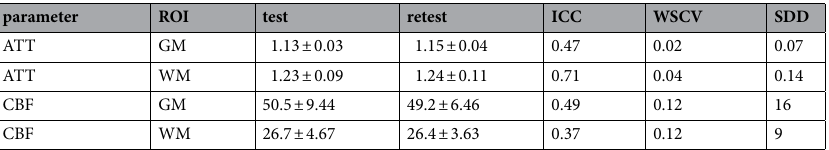
Table 1. Perfusion parameter results. Mean arterial transit time (ATT [s]) and cerebral blood flow (CBF [ml/100 g/min]) and statistical test–retest results (ICC, WSCV, SDD) in white (WM) and gray matter (GM).